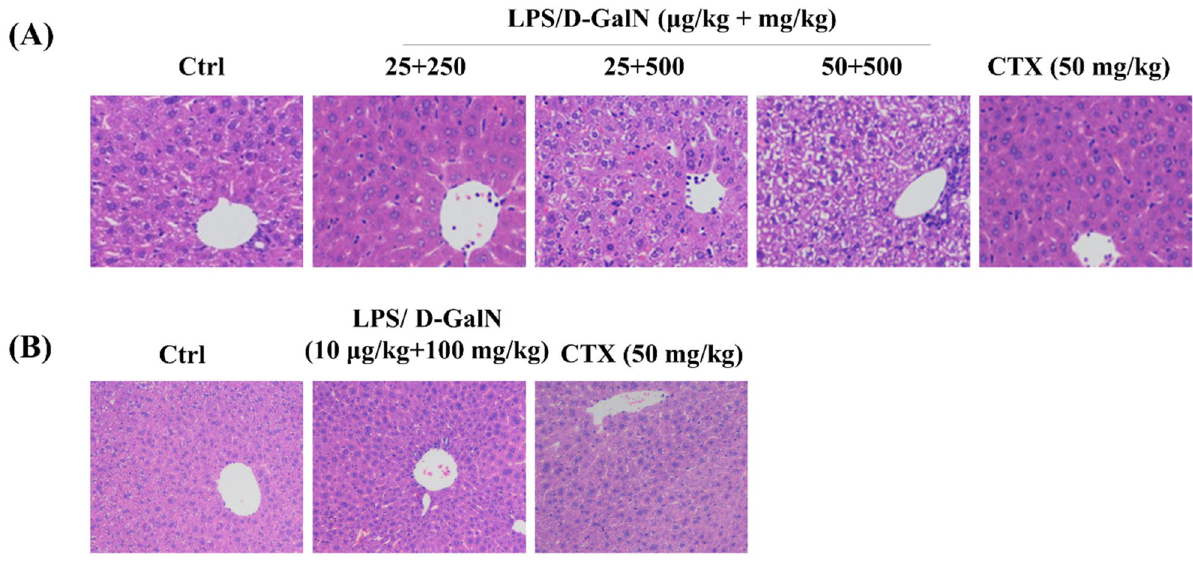
Figure 1. HE staining indicating LPS/D-GalN-induced liver damage. ( A ) Acute treatment. Mice were injected with LPS/D-GalN (25 μg/kg + 250 mg/kg, 25 μg/kg + 500 mg/kg and 50 μg/kg + 500 mg/kg body weight). After 6 h, HE staining was used to show the lesions of the liver in mice. ( B ) Chronic treatment: mice were injected with LPS/D-GalN (10 μg/kg + 100 mg/kg body weight) every other day for 8 weeks. Then HE staining was used to show the lesions of the liver in mice. Saline solution (0.9%) and cyclophosphamide (CTX) (50 mg/kg body weight) were used as negative and positive control, respectively. Original magnification: